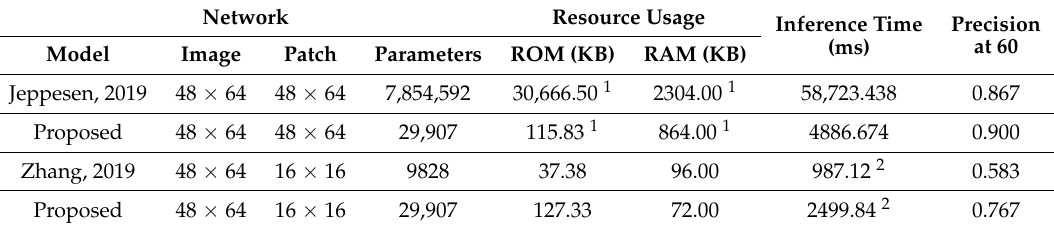
Table 2. Computational cost results for selected models. Inference time is only for CNN excluding image pre-processing time. ( 1 External memory used, 2 Inference time for 12 patches).